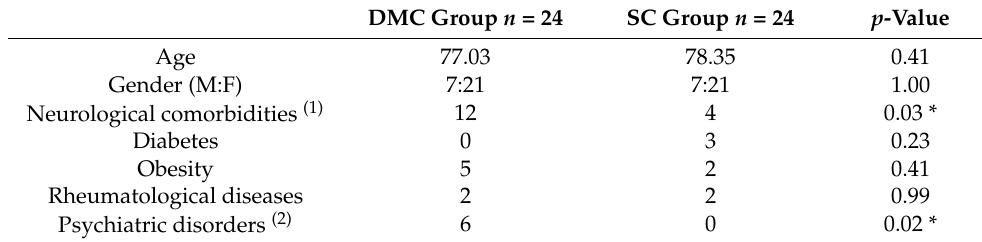
Table 1. Demographic and relevant clinical data of the study population.